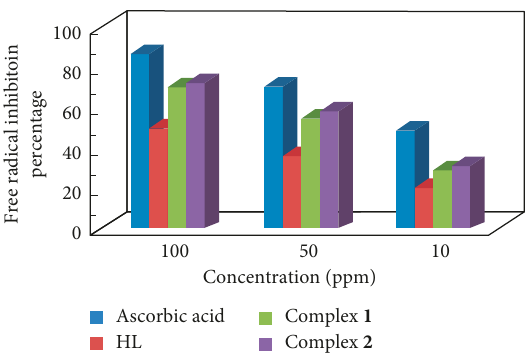
Figure 4: Antioxidant activity of the imine-based ligand (HL) and its metal complexes.